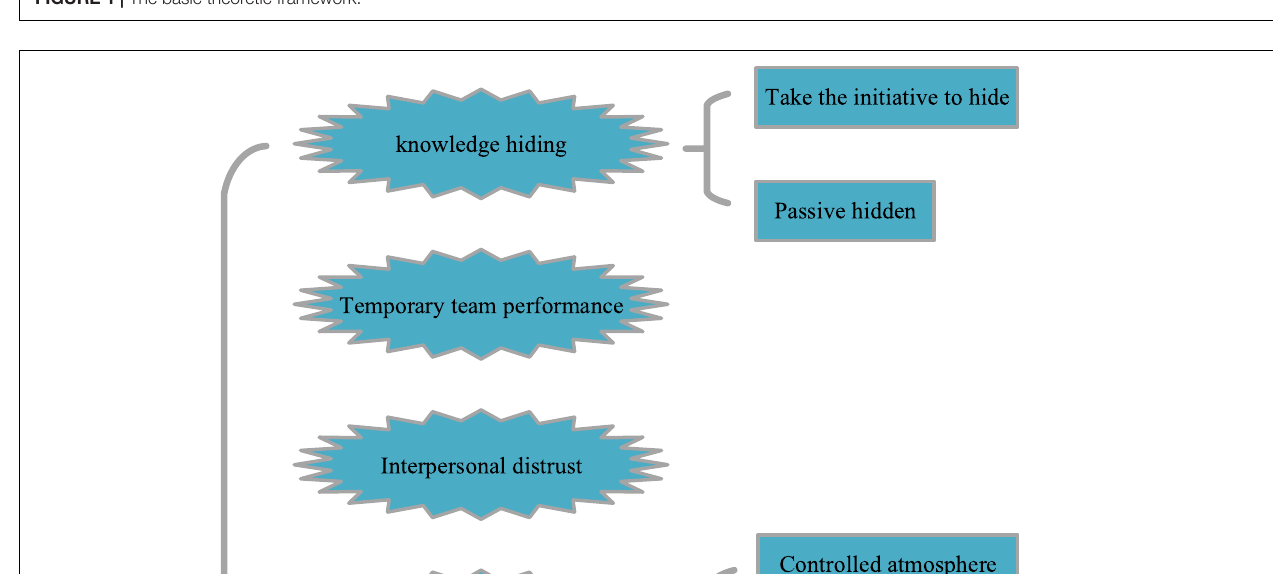
FIGURE 1 | The basic theoretic framework.